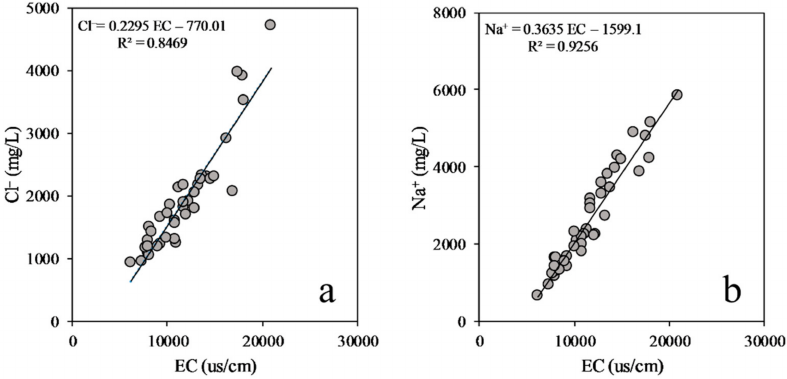
Figure 2. Relationship of ( a ) EC vs. Cl − ; ( b ) EC vs. Na + in the upper Dibdibba unconfined